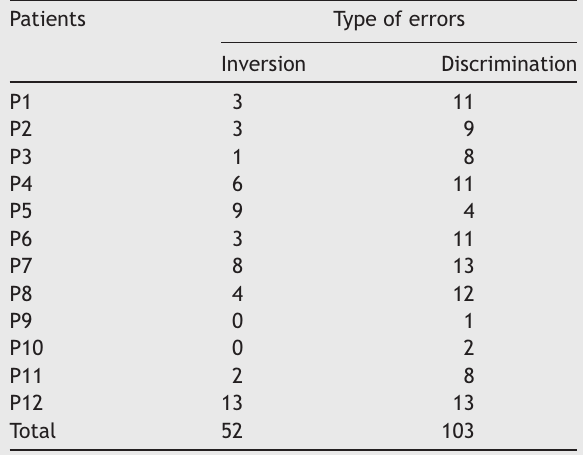
Types of errors in the study group in the Frequency Pattern